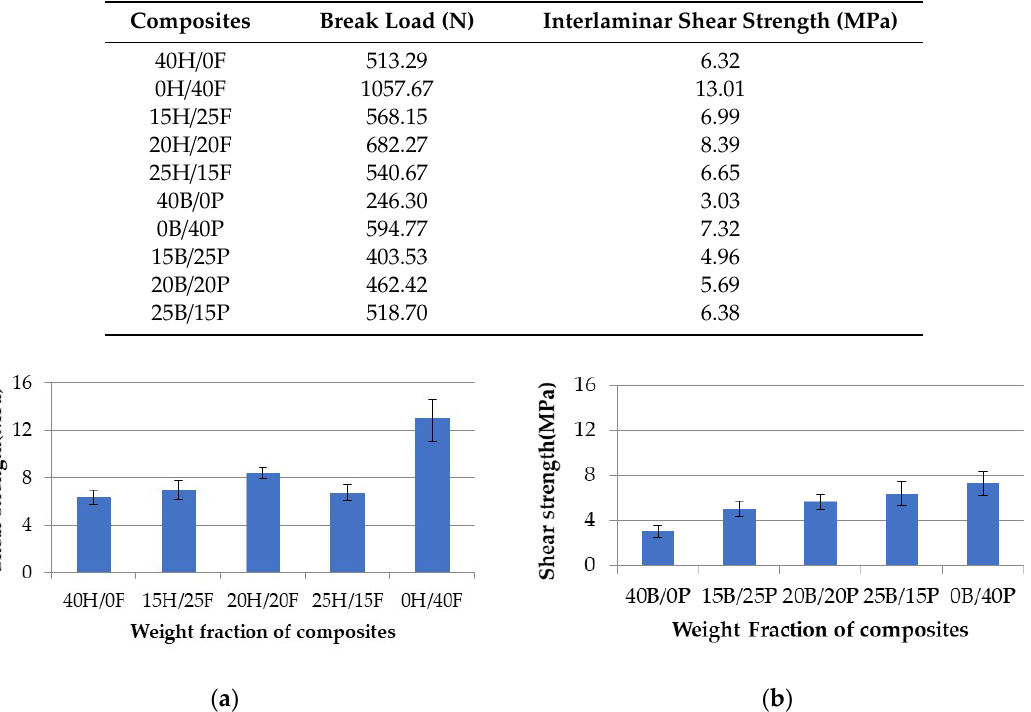
Table 4. Interlaminar shear strength properties.